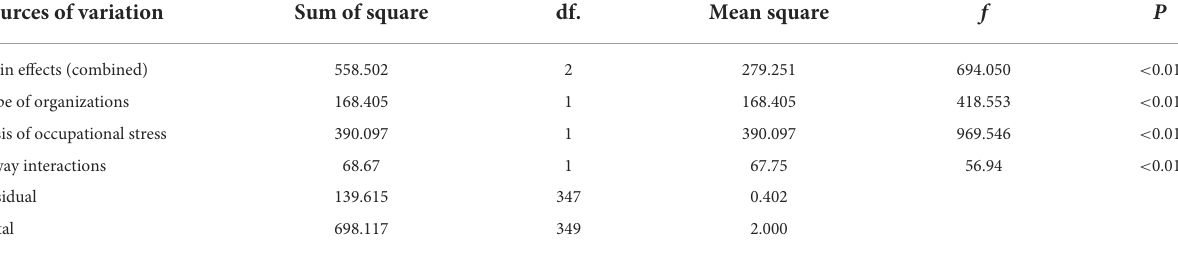
TABLE 11 Summary of two-way ANOVA for nature of health risk by type of organizations and basis of job stress of employees ( N = 350). Sources of variation Sum of square